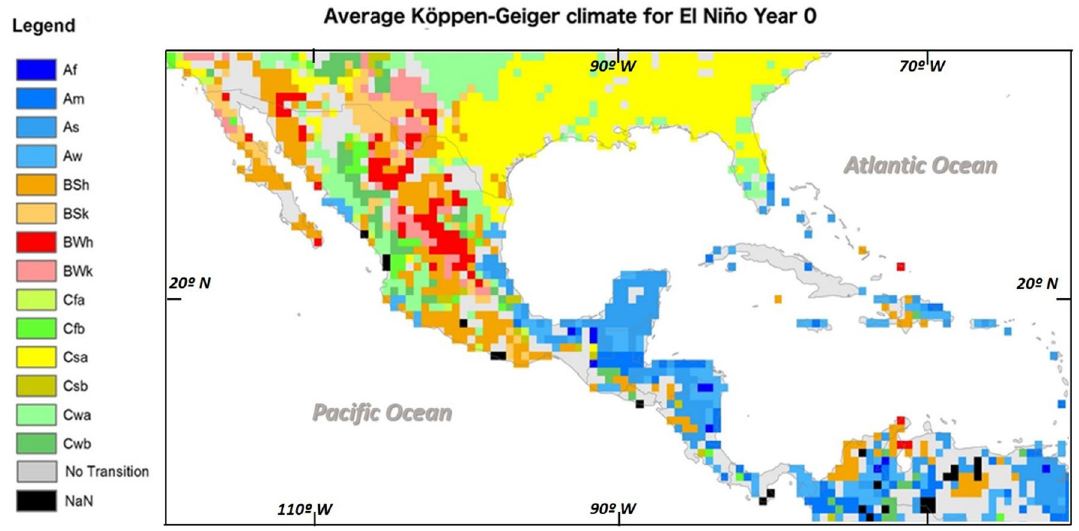
Fig. 5 Ko¨ppen–Geiger climate classification during El Nin˜o Year 0 based on five strong El Nin˜os in the Central American and circum- Caribbean